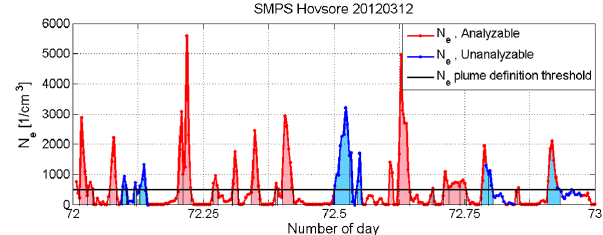
Figure 7. Number concentration of excess particles ( N e ) as func- tion of time during 12 March 2012. Unanalyzable time periods are marked with a blue line. Areas shaded with red are the analyzable plumes and areas shaded with blue are the unanalyzable plumes. Please note that even one unanalyzable data point makes the entire plume unanalyzable (e.g., the plume most to the